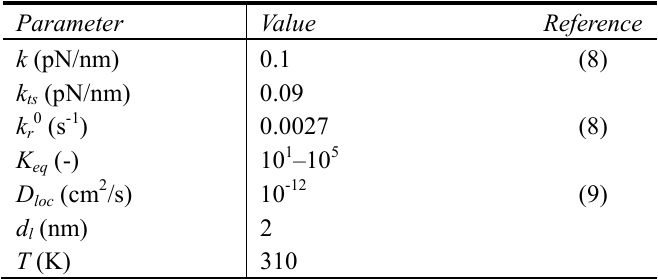
Table 1 Parameter values for the rates of GPIb α –vWF bond formation, breakage, and GPIb α